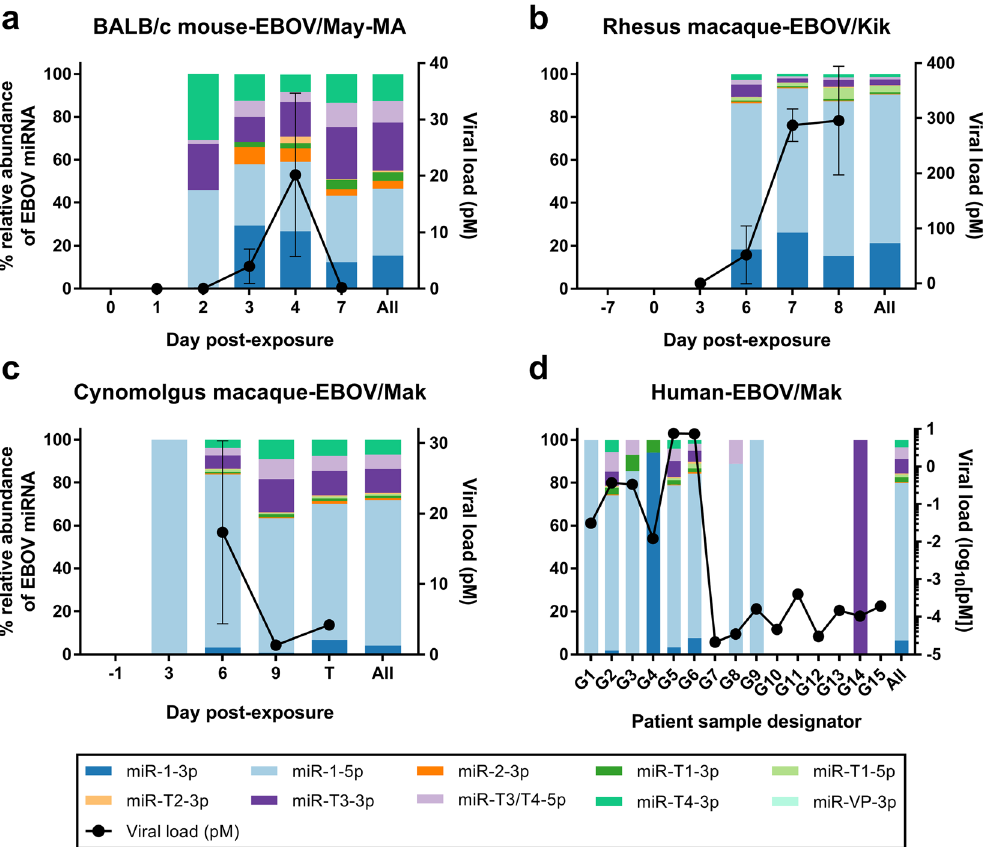
Figure 4. EBOV miRNA distributions are similar in different disease models. The relative abundance of each EBOV miRNA species detected was plotted as a percentage of the total EBOV miRNA content per day in the ( a ) BALB/c mouse model infected with mouse-adapted EBOV/Mayinga, ( b ) rhesus macaque model infected with EBOV/Kikwit, ( c ) cynomolgus macaque model infected with EBOV/Makona, and ( d ) human samples from the EBOV/Makona outbreak in 2014. In the animal models, samples were grouped by day post-exposure, whereas human samples are shown individually and arranged by day post-symptom onset. The aggregated miRNA distributions for each model are given in the last bar for each graph. EBOV viral loads (mean ± SD of biological replicates, where applicable, assayed in technical triplicate) are shown for comparative purposes, and filled circles represent a positive PCR result for the viral glycoprotein